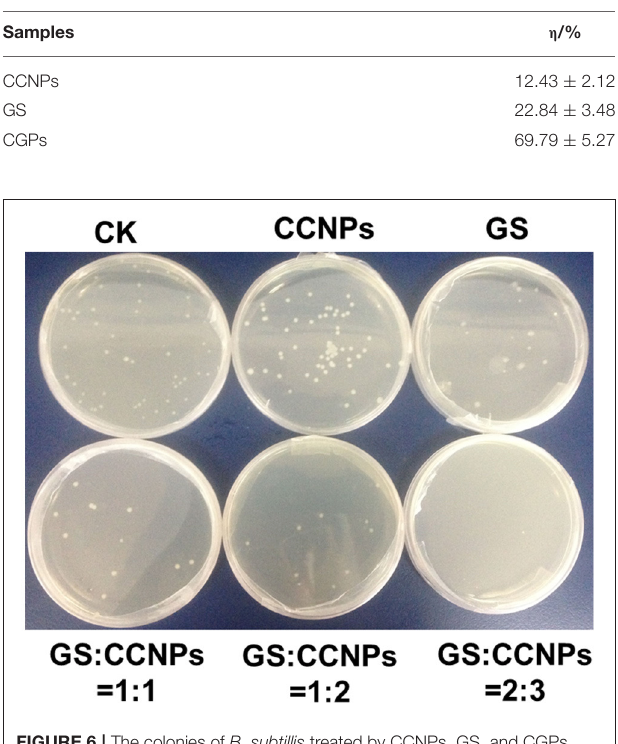
FIGURE 6 | The colonies of B. subtillis treated by CCNPs, GS, and CGPs.